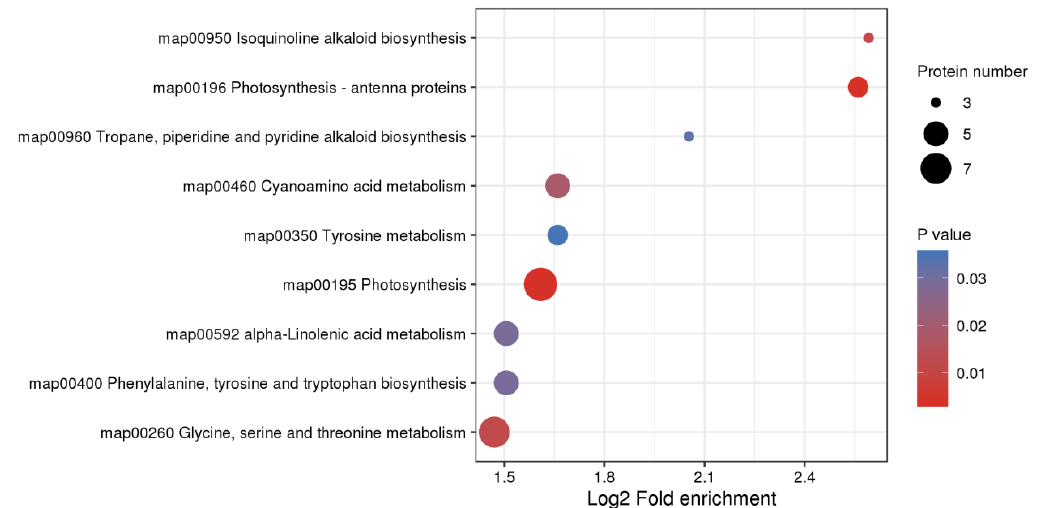
Figure 9. KEGG enrichment analysis of differentially expressed proteins (DEPs). KEGG enrichment analysis was performed for each protein class by Fisher’s exact test method, and the enrichment results for different classifications were combined. Then, the top 40 ( p < 0.05) significantly enriched functional classifications were identified. The horizontal axis shows fold enrichment after Log 2 transformation, the vertical axis shows the functional classification, the bubble size represents the number of proteins, and the bubble color represents the value of p of enrichment significance.